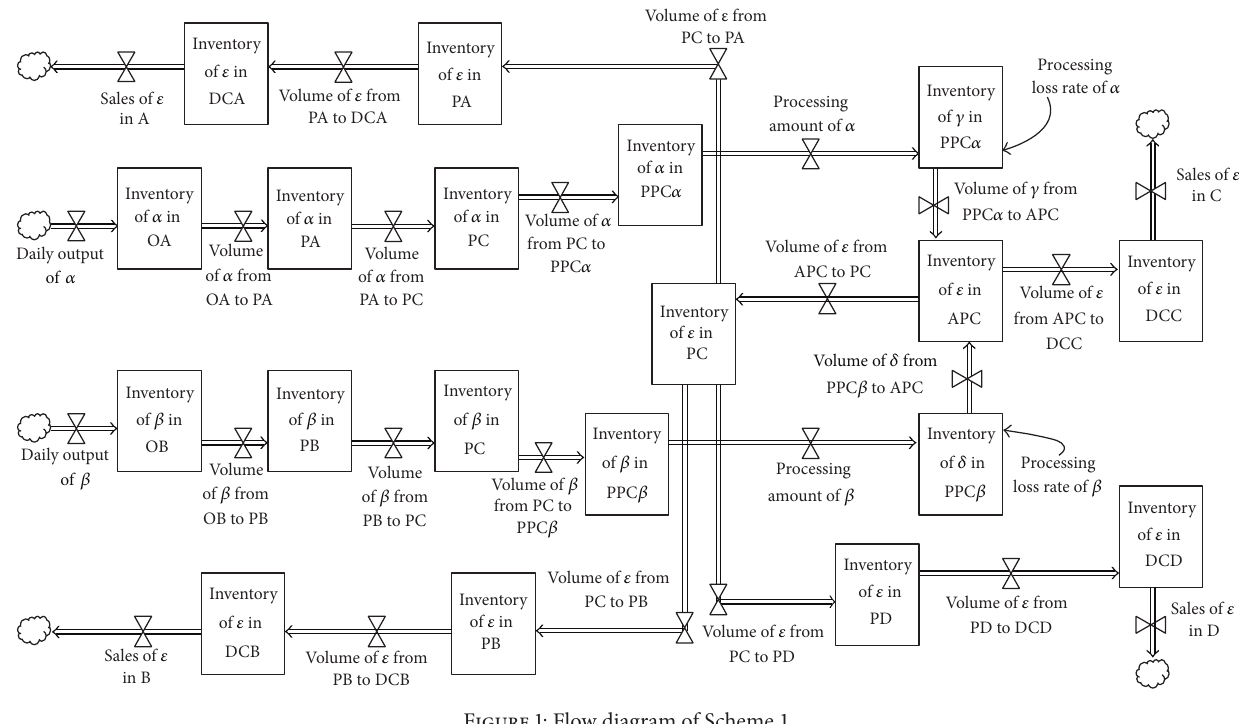
Figure 1: Flow diagram of Scheme 1